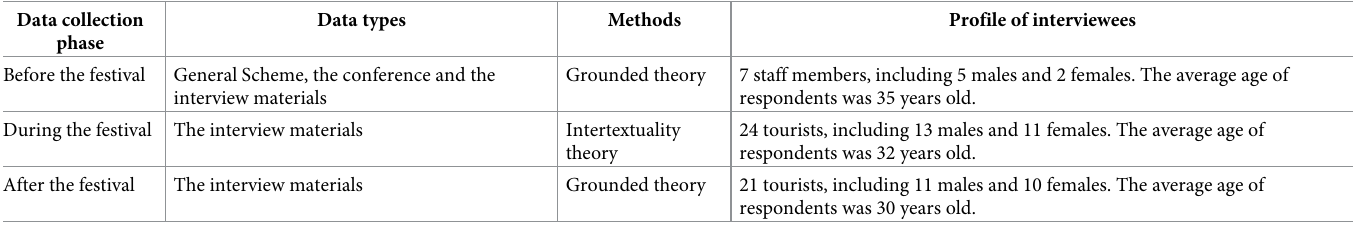
Table 1. Details of data collection of Guangfu Temple